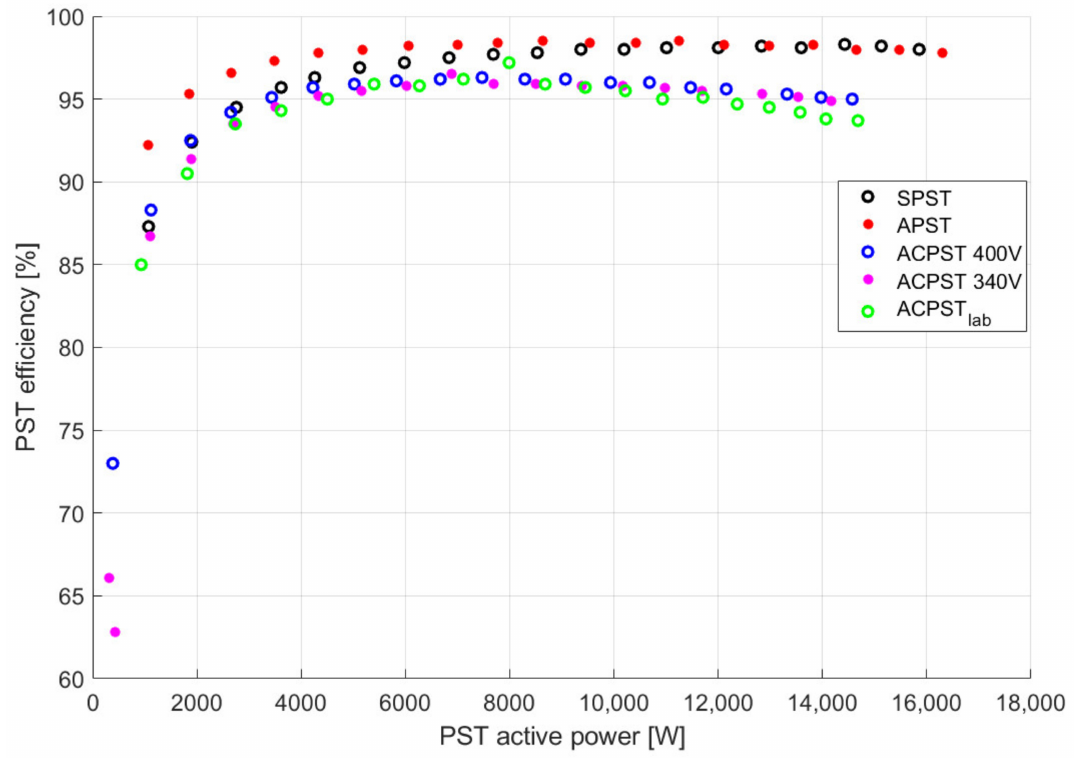
Figure 12. The efficiency of PSTs in transmitted active power function.